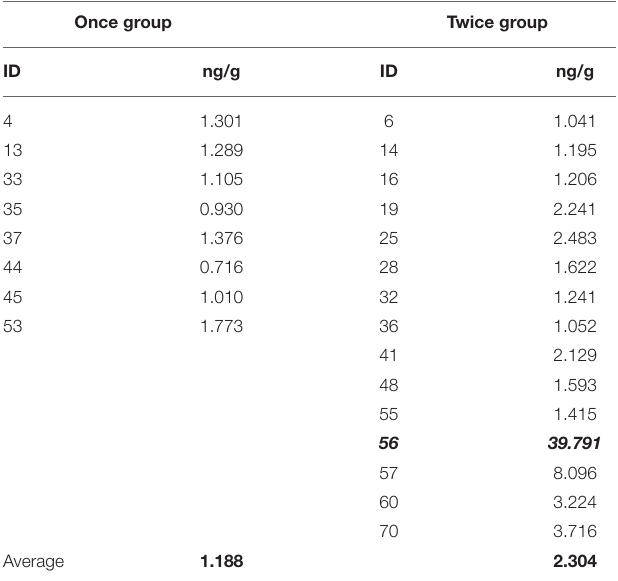
TABLE 2 | The cortisol concentrations of the Once and Twice shorn treatment groups. Once group Twice